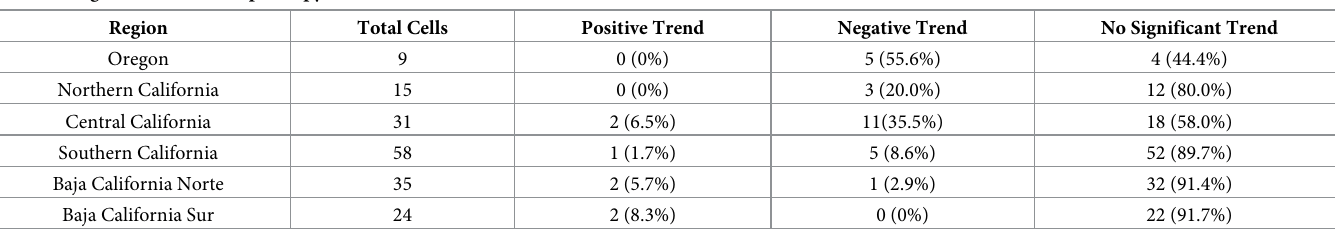
Table 1. Regional trends in kelp canopy.